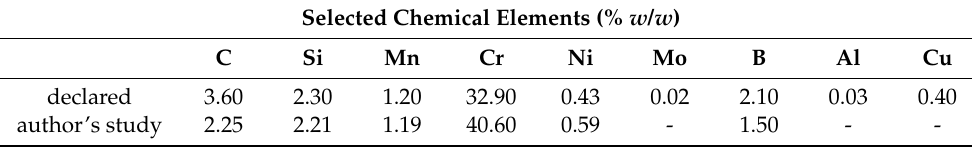
Selected Chemical Elements (% w / w )